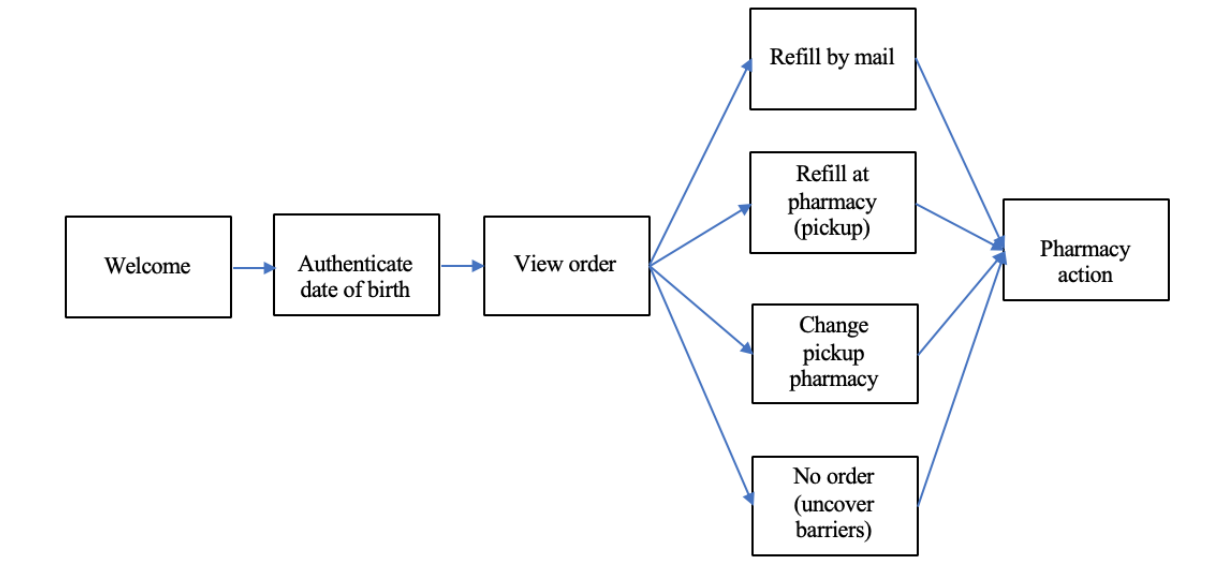
Figure 1. Overview of message flow within refill